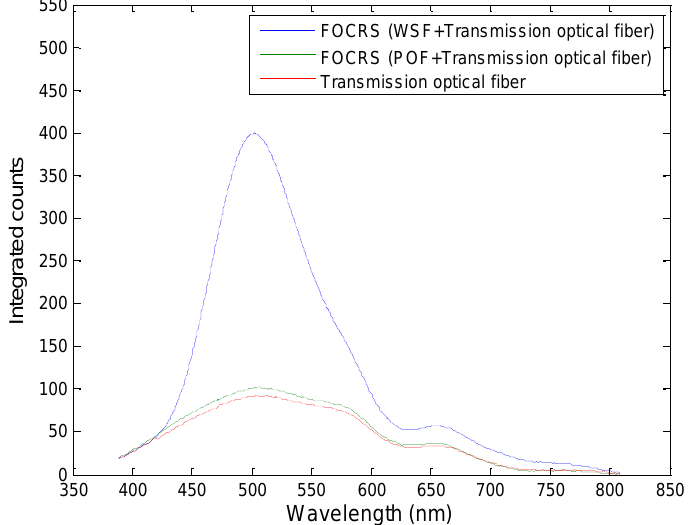
Figure 8. Spectra of light outputs generated in